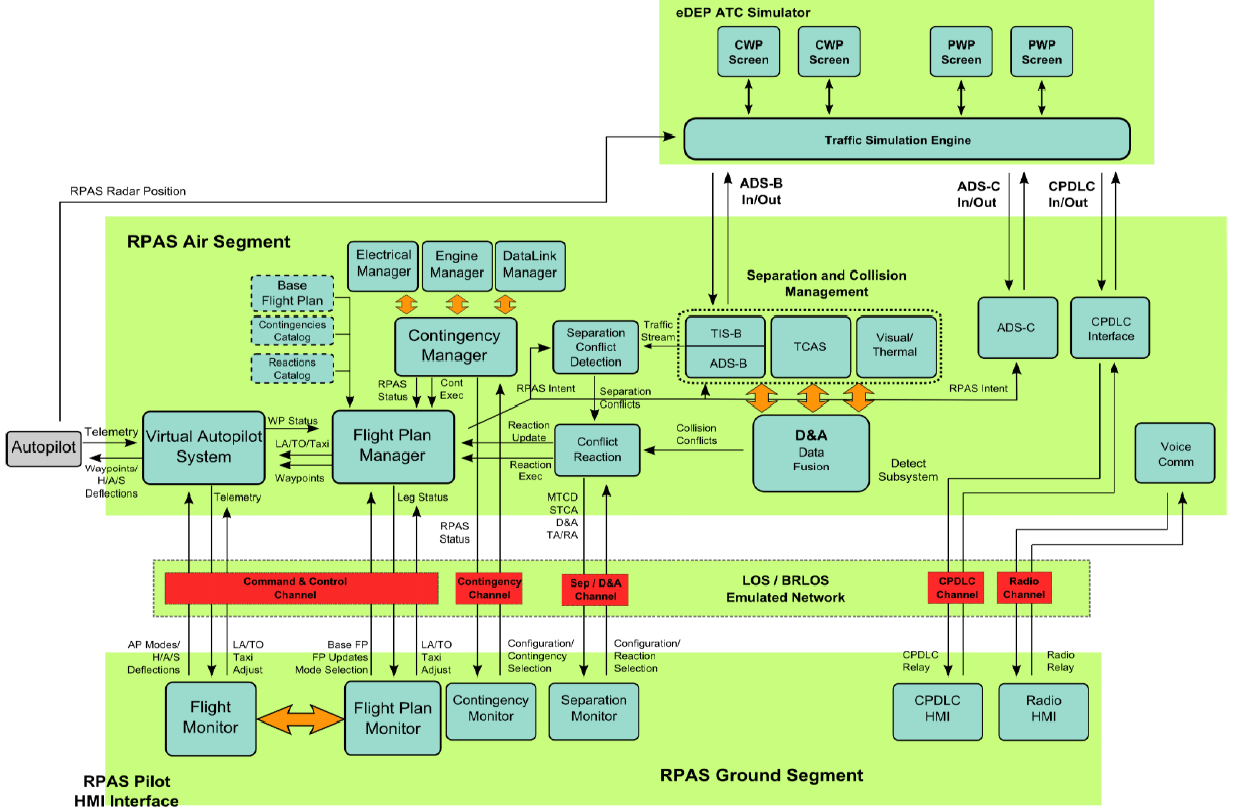
Figure 4. Simulation subsystems, interfaces, and datalinks employed in the ERAINT project